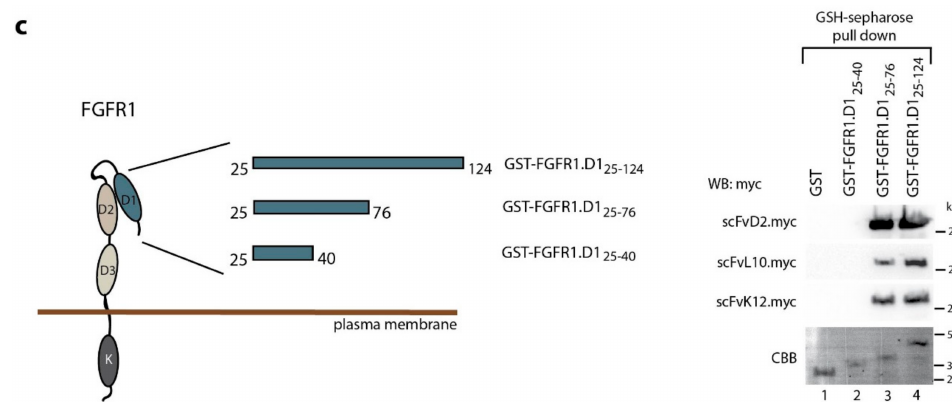
Figure 1. Engineered antibodies recognize the same epitope within the extracellular region of FGFR1. ( a ) SPR-based epitope binning. FGFR1.D1-D2-D3-Fc was immobilized on sensors and incubated with high concentrations of saturating antibodies. Next, competing antibodies were injected to assess if their binding to the extracellular region of FGFR1 is blocked by saturating antibodies. ( b ) SPR analysis of the interaction of scFv proteins with FGFR1 truncations. CM5 sensors were coated with FGFR1.D1-D2-D3-Fc, FGFR1.D2-D3-Fc, or GST-FGFR1-D1 25–124 , and the association and dissociation were monitored for 240 s after injection of scFv proteins (1 µ M), or FGF1 (1 µ M). ( c ) Pull down experiments with scFv proteins and truncated variants of the D1 domain of FGFR1. GST and GST-tagged truncated versions of the D1 domain were bound to Glutathione Sepharose and incubated with scFv proteins. After extensive washing, bound proteins were eluted and analyzed by Western blotting. Membranes were first stained with CBB to visualize eluted proteins and then detected with anti-c-myc antibodies (for visualization of scFv proteins containing C-teminal